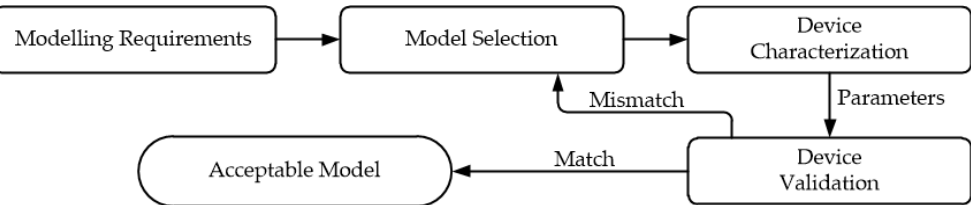
Figure 1. Block diagram for power device modelling.